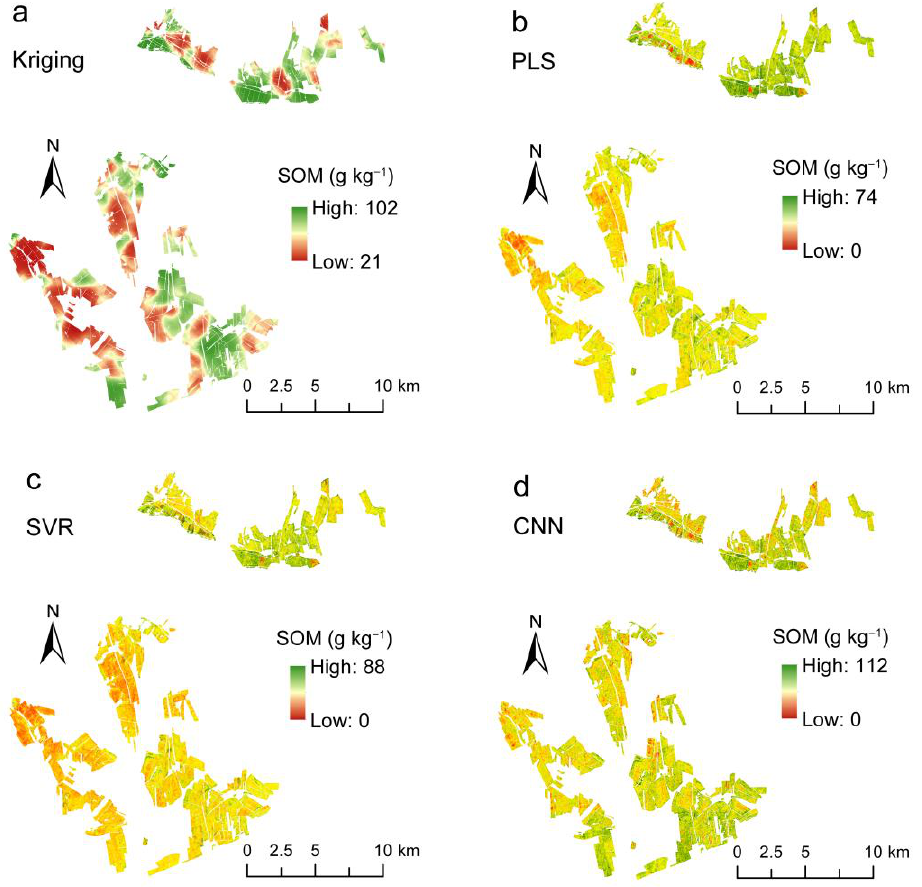
Figure 7. Estimated spatial distribution of SOM content in the study area using Kriging ( a ), partial least square (PLS, ( b )), support vector regression (SVR, ( c )), and convolutional neural network (CNN, ( d )) models.